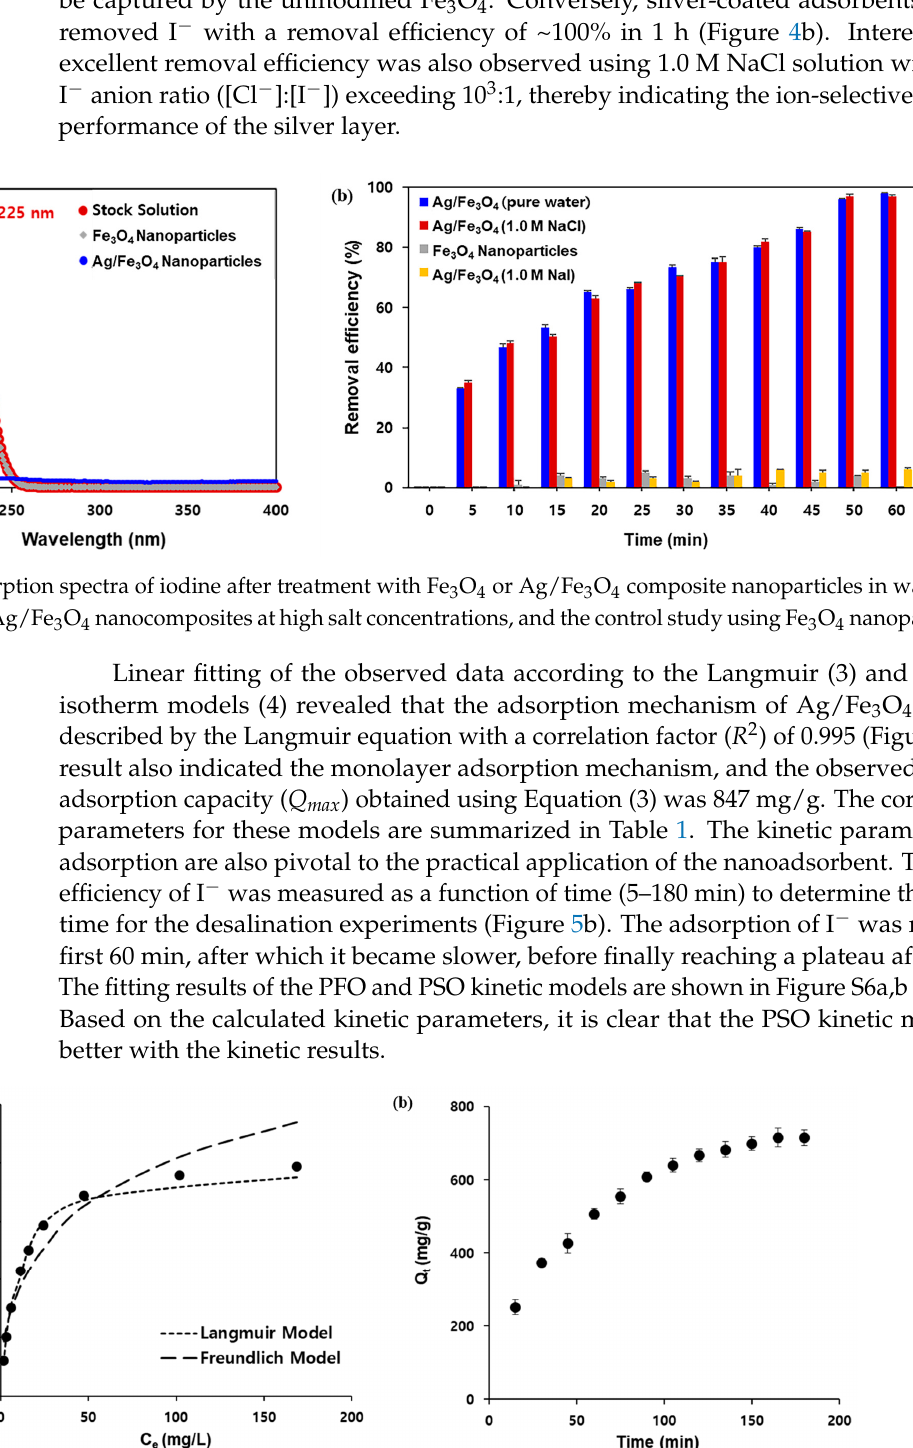
Figure 5. ( a ) Adsorption isotherm study employing the Langmuir and Freundlich models, ( b ) absorption kinetics as a function of time. Table 1. Calculated parameters for the adsorption isotherm fittings for the Ag/Fe 3 O 4 nanocompo- sites. ( R 2 = coefficient of determination) Isotherm Type Parameters R 2 Langmuir Model Q max = 846.860 mg/g